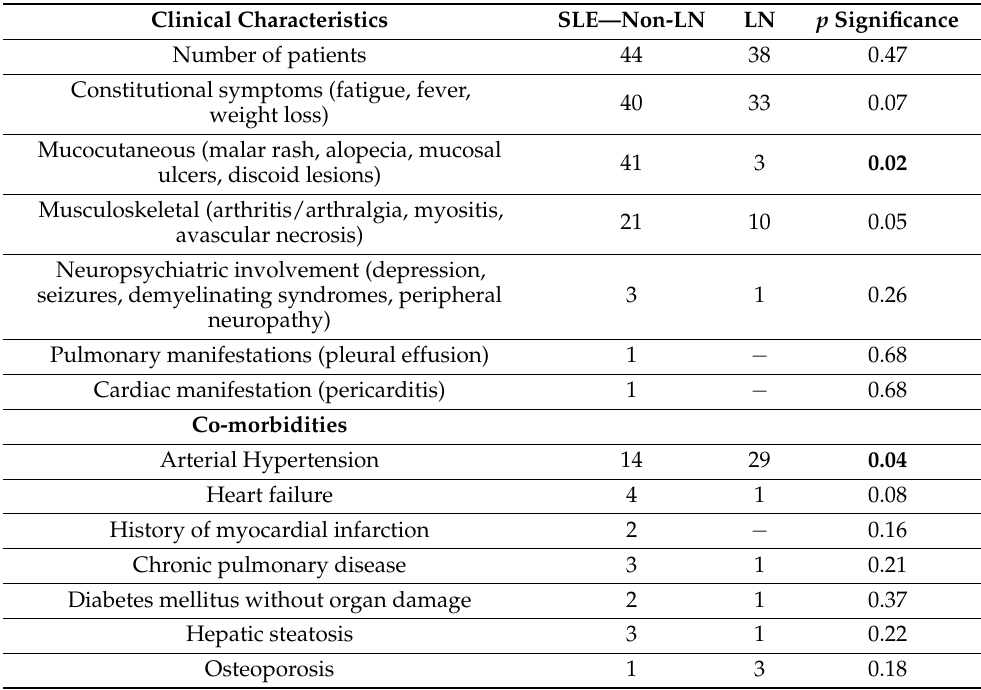
Table 2. Clinical characteristics of the SLE